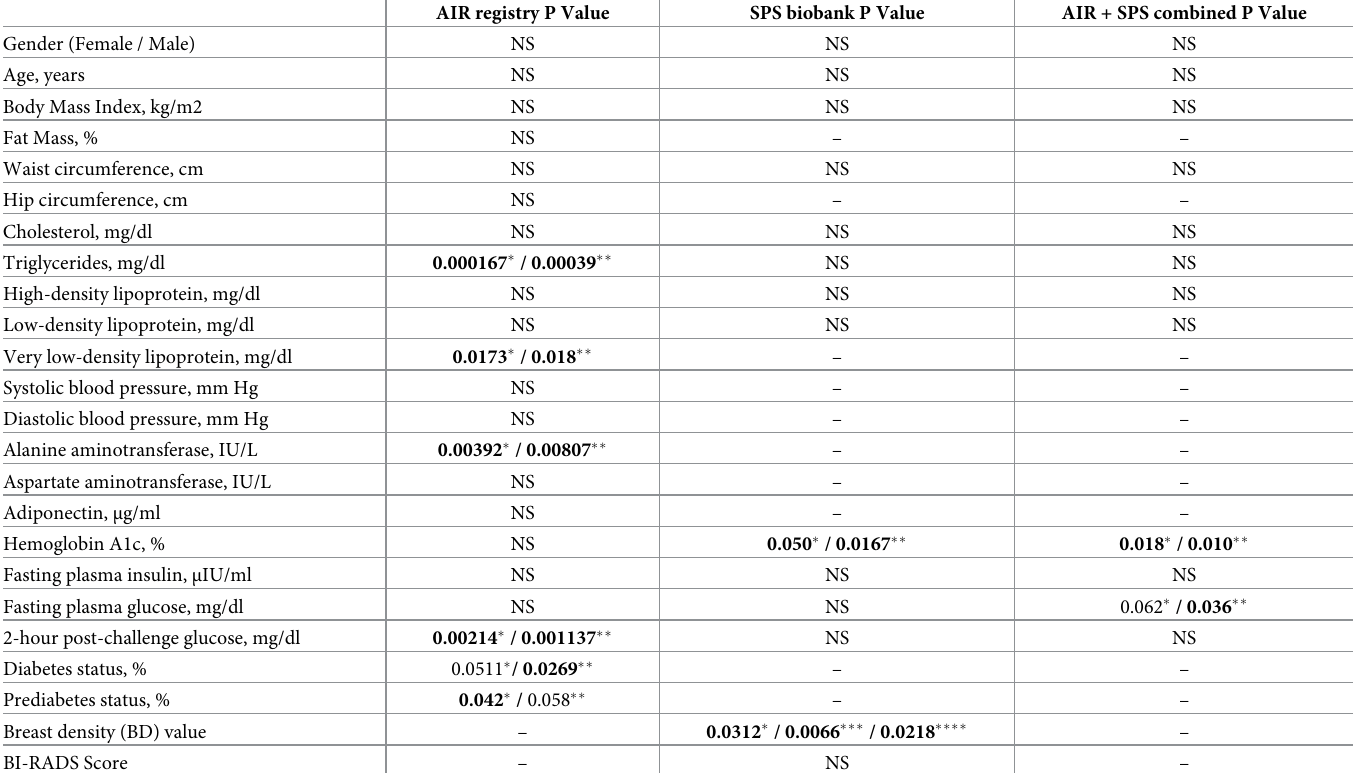
Table 3. Summary table of the EDARV370A association analysis by phenotypes for AIR registry, SPS biobank and AIR + SPS